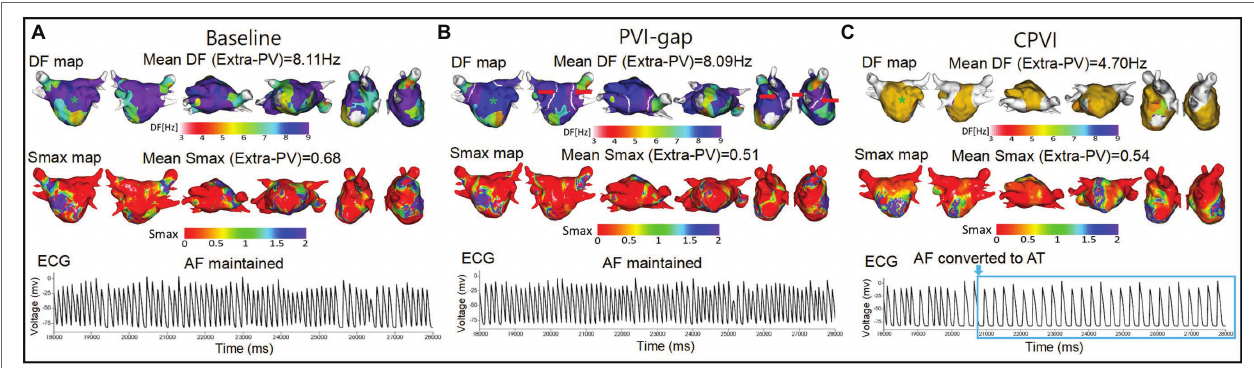
FIGURE 2 | Wave-dynamic changes after the virtual PVI-gap and CPVI. (A) The ECGs were obtained at the blue * sites in the DF maps. (B) The red arrows indicate gaps in the PVI. (C) The 3D DF maps and ECGs indicate that the CPVI reduced the mean DF, increased the AF cycle lengths, and defragmented the AF, but the PVI-gap did not. However, neither the CPVI nor PVI-gap changed the Smax. DF indicates dominant frequency; Smax, the maximal slope of the restitution curves; PVI-gap, pulmonary vein isolation with gaps; CPVI, complete pulmonary vein isolation; AF, atrial fibrillation; AT, atrial tachycardia; ECG,